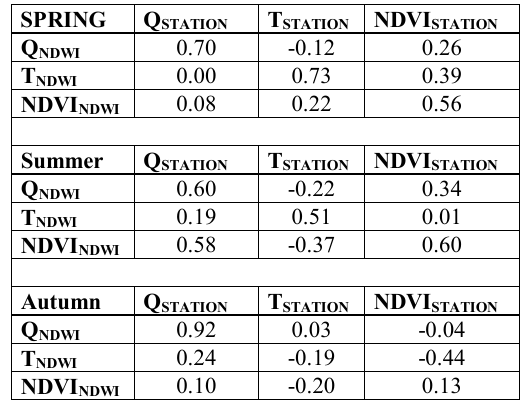
Table 4. The correlation coefficients between the precipitation (Q), air temperature (T) and NDVI obtained for the growing seasons on the base of ground observations (Q STATION , T STATION ,